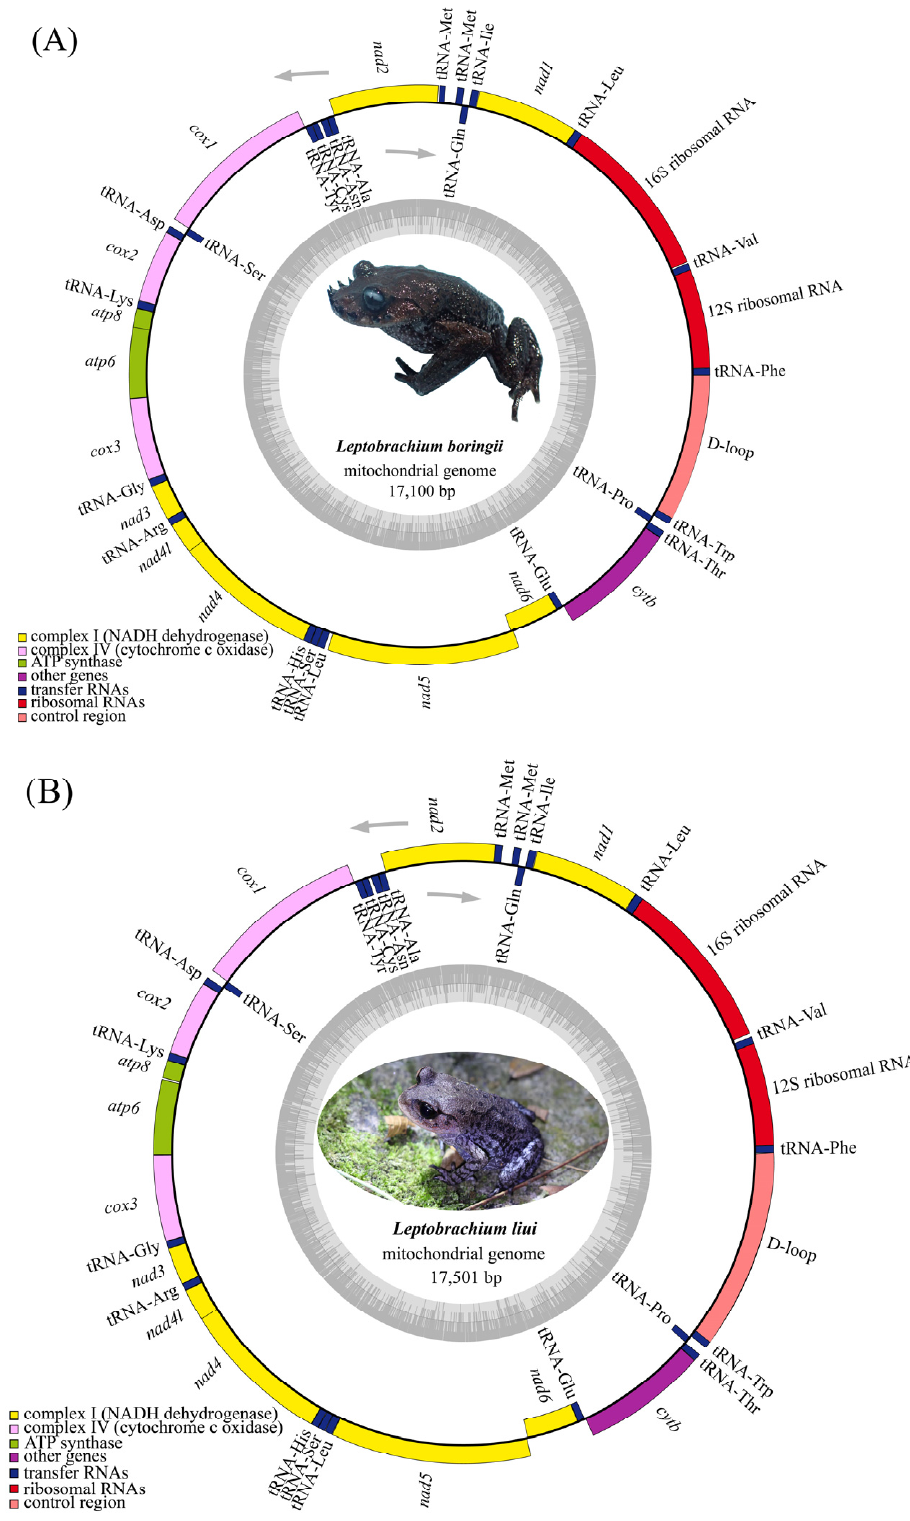
Figure 2. Gene map of the mitogenome of L. boringii ( A ) and L. liui ( B ).